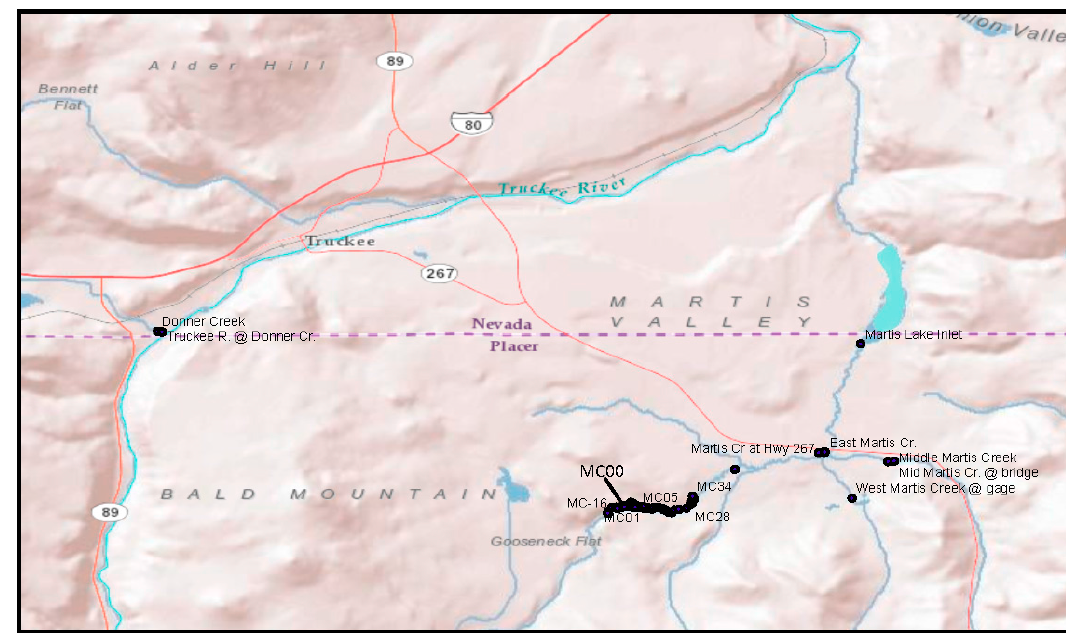
Figure A2. Surface water locations noted in Table A2.